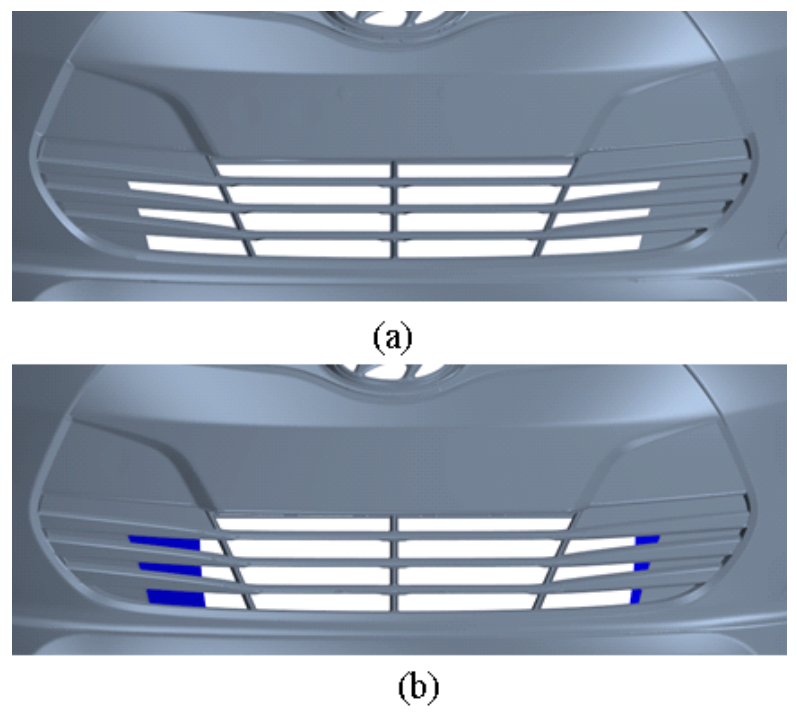
Figure 3. Front grille opening; ( a ) front grille with no side grille sealing as used in Case 1, ( b ) the front grille with both side grilles sealed off as used in Case 2. The blue colored parts indicate how the side grilles were sealed